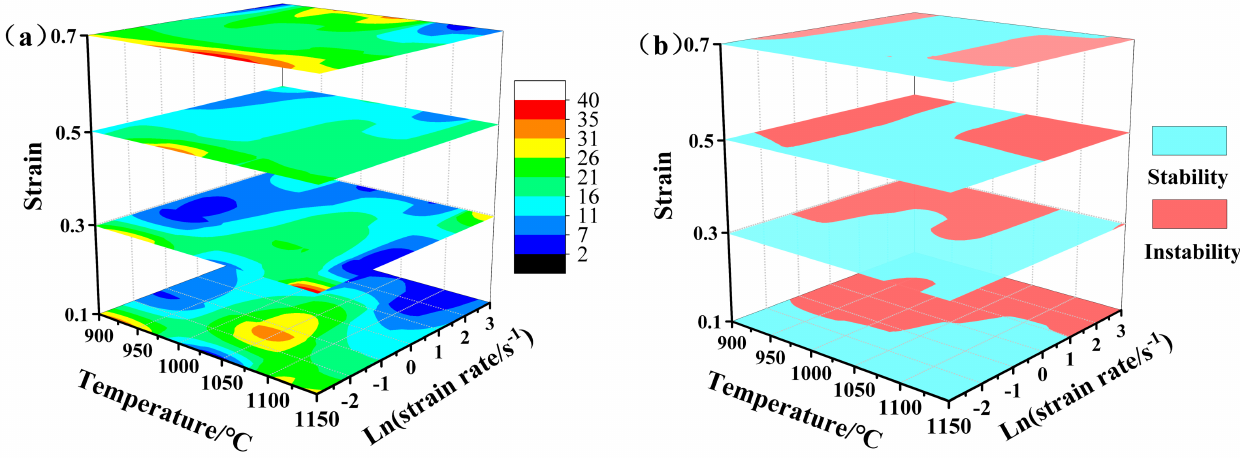
Figure 9. 3D power dissipation maps ( a ) and instability map ( b ) of the newly designed Fe–5Mn–3Al–0.1C.